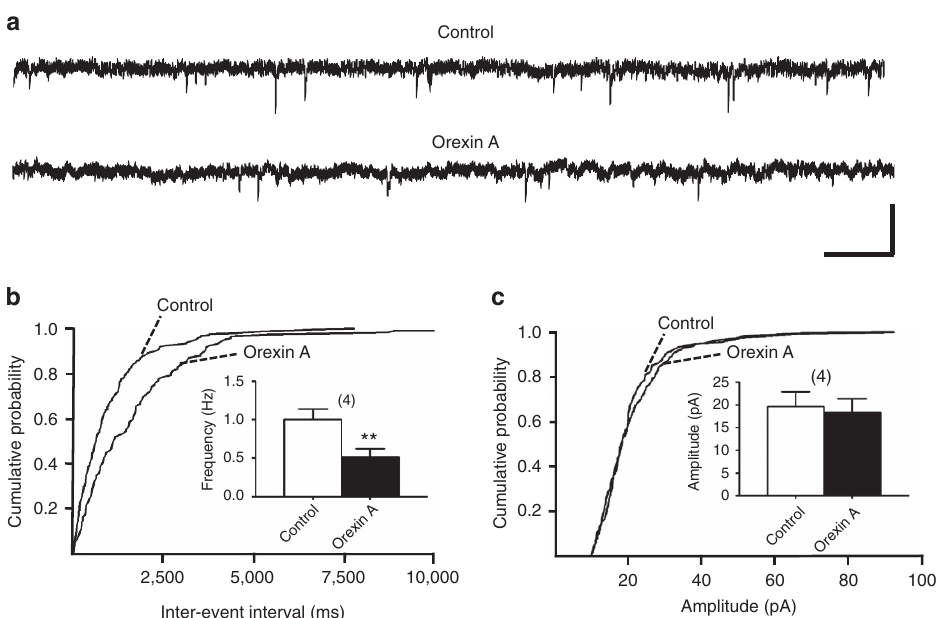
Figure 2 | Orexin A decreased the frequency, but not the amplitude, of mIPSCs. ( a ) Representative traces of mIPSCs recorded in the presence of 2mM kynurenic acid and 1 m M tetrodotoxin in a neuron before (upper panel) and 10min after (lower panel) treatment with 100nM orexin A. Scale bars, 0.5s and 50pA. ( b , c ) Cumulative probability of the interval or amplitude of mIPSCs, sampled in a 5-min period, before and 10min after treatment with 100nM orexin A (black bars). Insets: ( b ) the average frequency ( n ¼ 4, P ¼ 0.0028 ; t (3) ¼ 9.127) and ( c ) amplitude ( n ¼ 4, P ¼ 0.1142 ; t (3) ¼ 2.209) of mIPSCs before and 10min after treatment with orexin A in the same neurons. ** P o 0.01 versus control (paired t -test). Data are expressed as mean ±